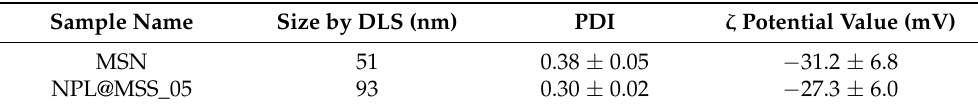
Table 2. Size analysis by dynamic light scattering and ζ - potential measurement for MSN